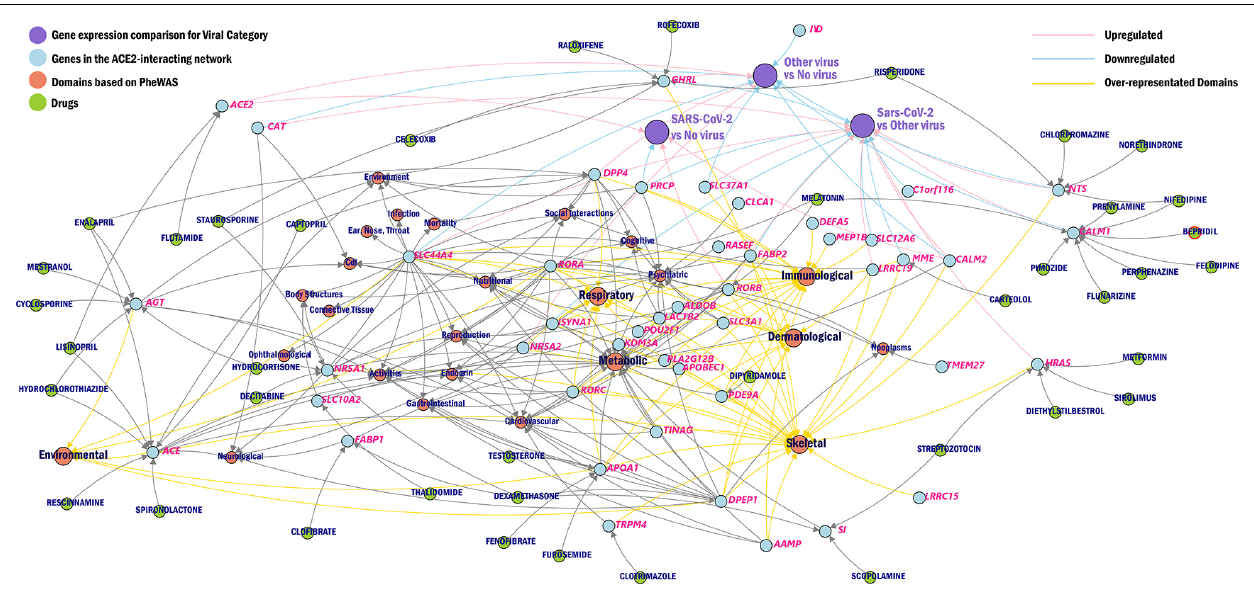
FIGURE 5 | Network of ACE2 interacting genes. The overview of ACE2-network genes (blue) as drug targets (green), phenotype domains (red), and gene expression category (purple) wherein the genes are significant from the CZBioHub (see text for details). The pink edges represent upregulation and blue edges represent downregulation, and yellow edges connect genes to overrepresented phenotype